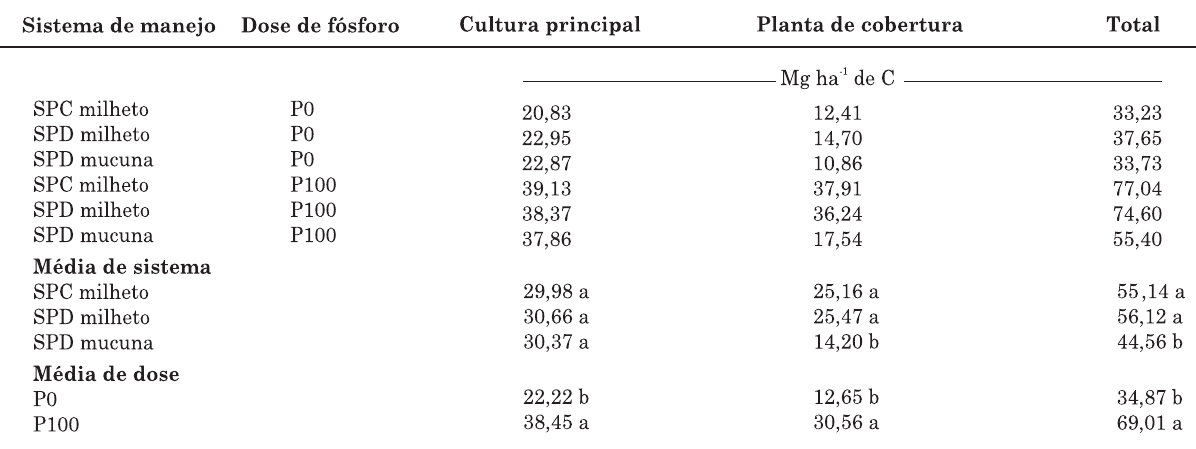
SPC: sistema de preparo convencional, SPD: sistema plantio direto. P0: 0 e P100: 100 kg ha -1 ano -1 de P triplo aplicado no sulco de semeadura. Médias seguidas da mesma letra na coluna não diferem entre si pelo teste de Student (p <